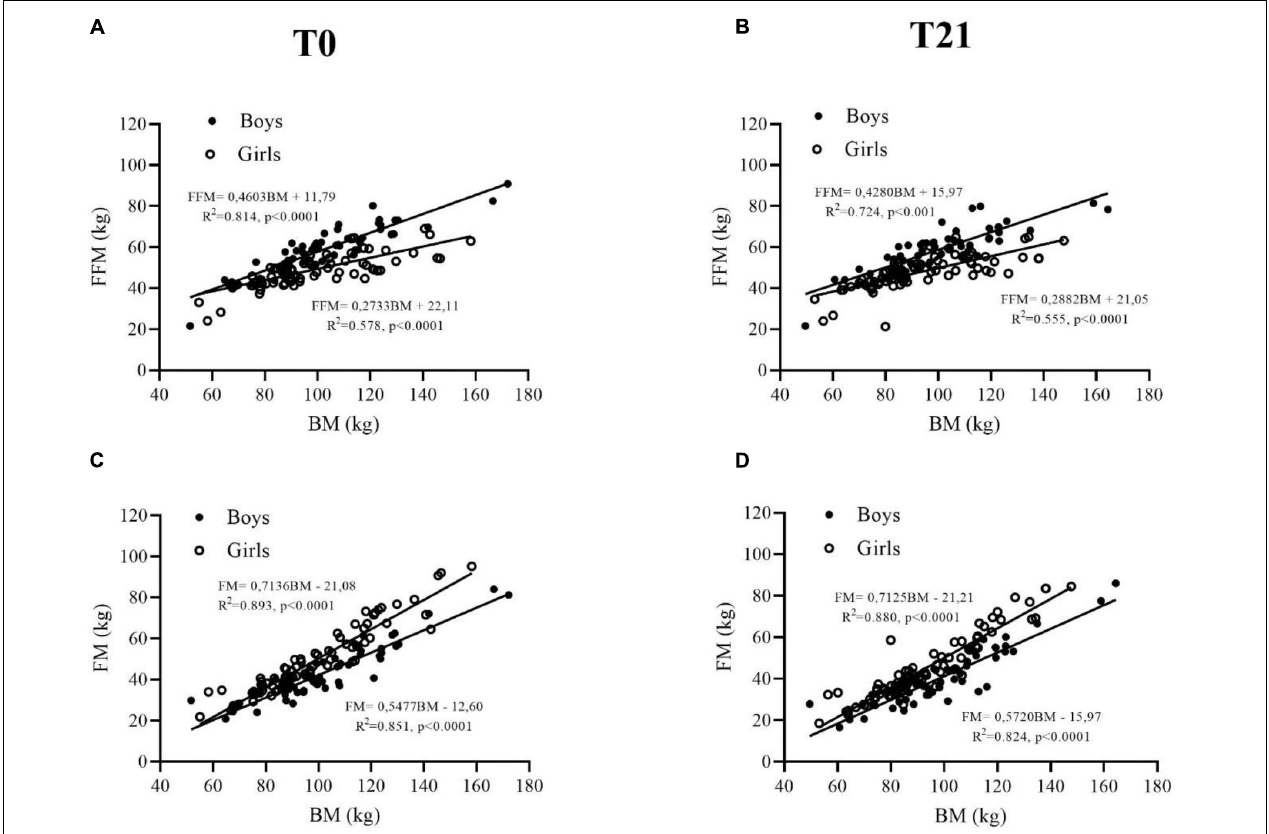
FIGURE 1 | Fat-free mass (FFM) (A,B) and fat mass (FM) (C,D) are plotted as a function of body mass in adolescent obese boys (closed symbols) and girls (open symbols) before (T0) and after (T21) the 3-week BWRP.